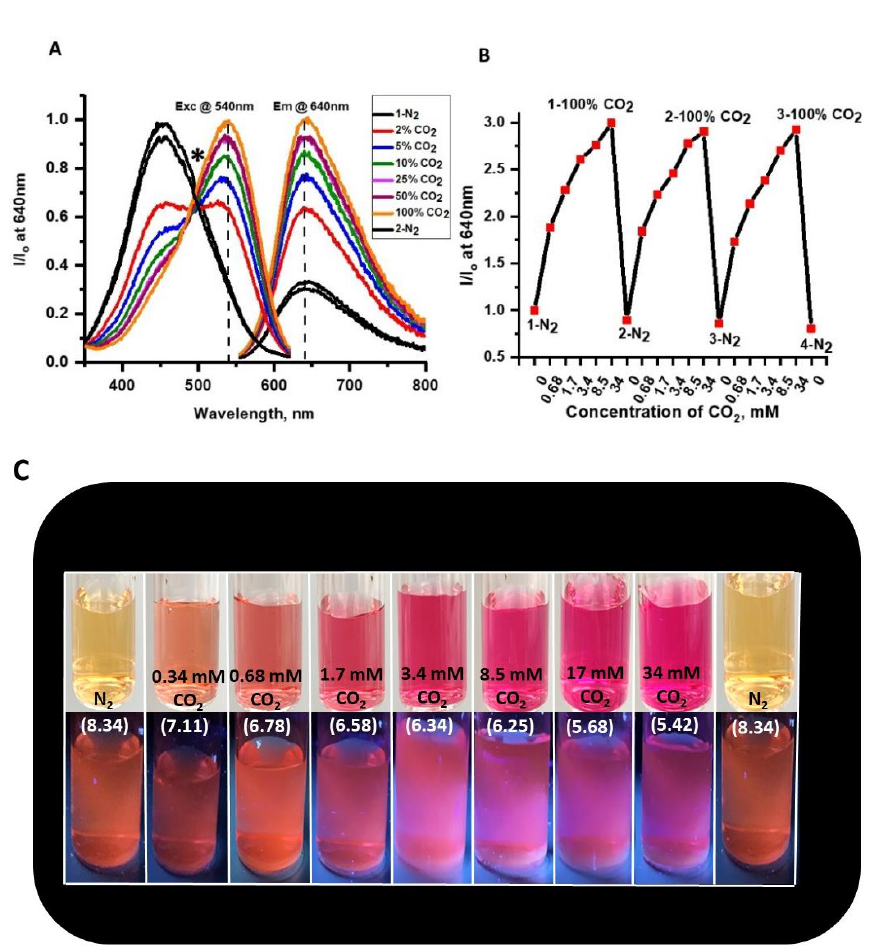
Figure 5. Changes in absorption of NR buffer solution (pH 7.3) purged with different concentrations of CO 2 gas (0.0 mM, 0.68 mM, 1.7 mM, 3.4 mM, 8.5 mM, 17.0 mM, 34.0 mM — 0%, 2%, 5%, 10%, 25%, 50%, and 100%, respectively). ( A ) Changes in full absorption spectra. The ‘*’represents the isosbestic point at around 470 nm. ( B ) Changes in absorption signal vs. pH at 540 nm wavelength for one cycle at different gas concentrations.